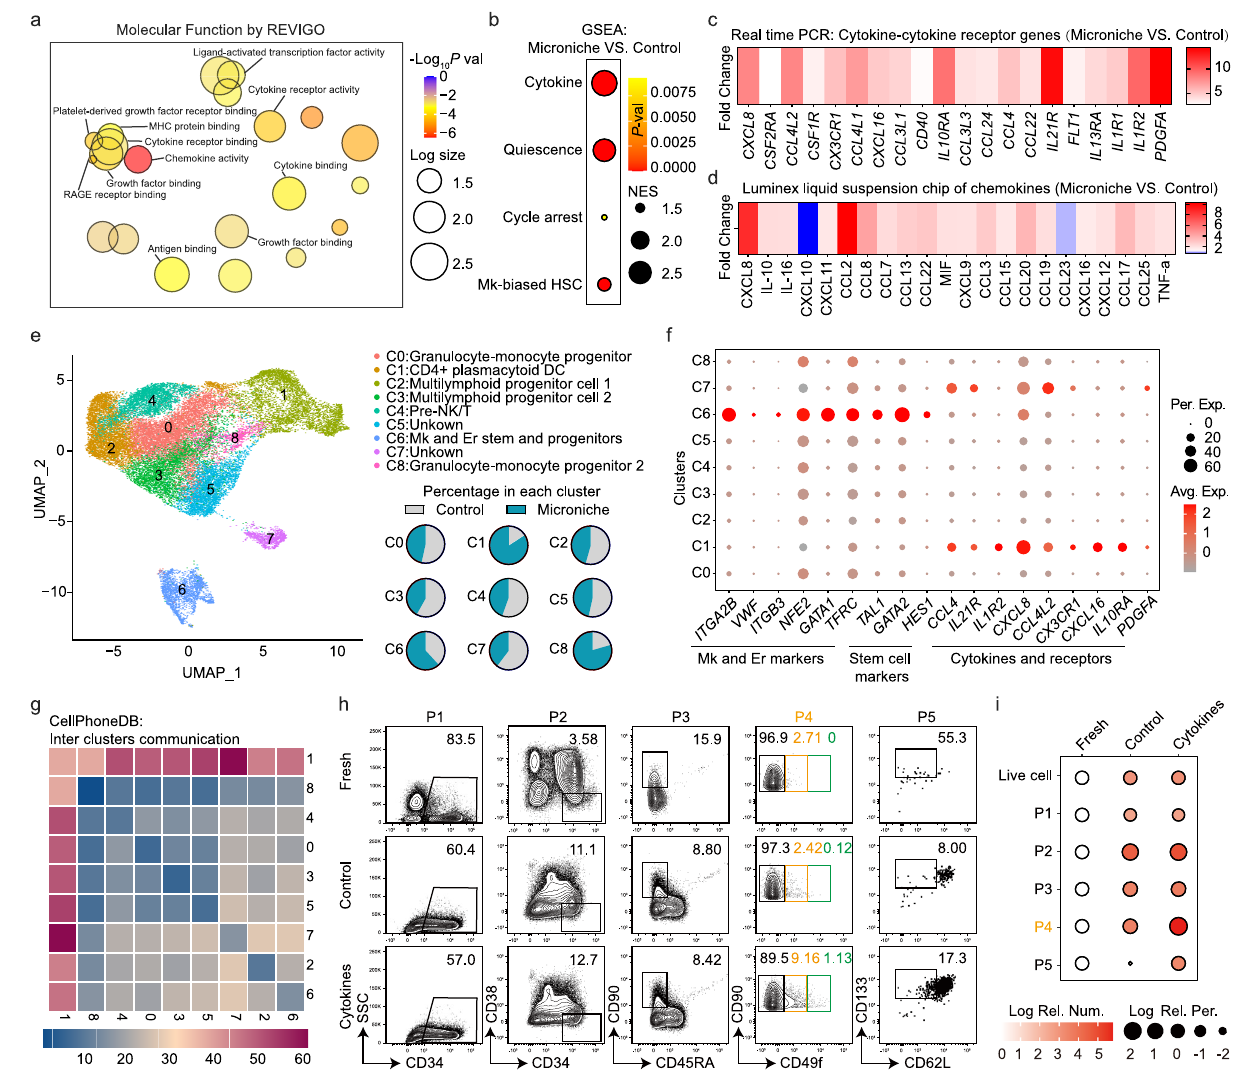
Fig. 5 | Cytokine pro fi les between control medium and Microniche. a REVIGO interactive graph of major Gene Ontology molecular function (GO MF) terms in RNA-seq of sorted CD34 + cells after culture. Bubble color indicates − Log 10 p value; bubble size indicates GO term frequency. b GSEA of the indicated gene sets enri- ched in Microniche vs. control.Bubblesize indicates normalized enrichment score (NES);bubblecolorindicates p value. c Heatmapof averagerelative expression for cytokine-cytokine receptor genes enriched in Microniche-cultured CD34 + cells.